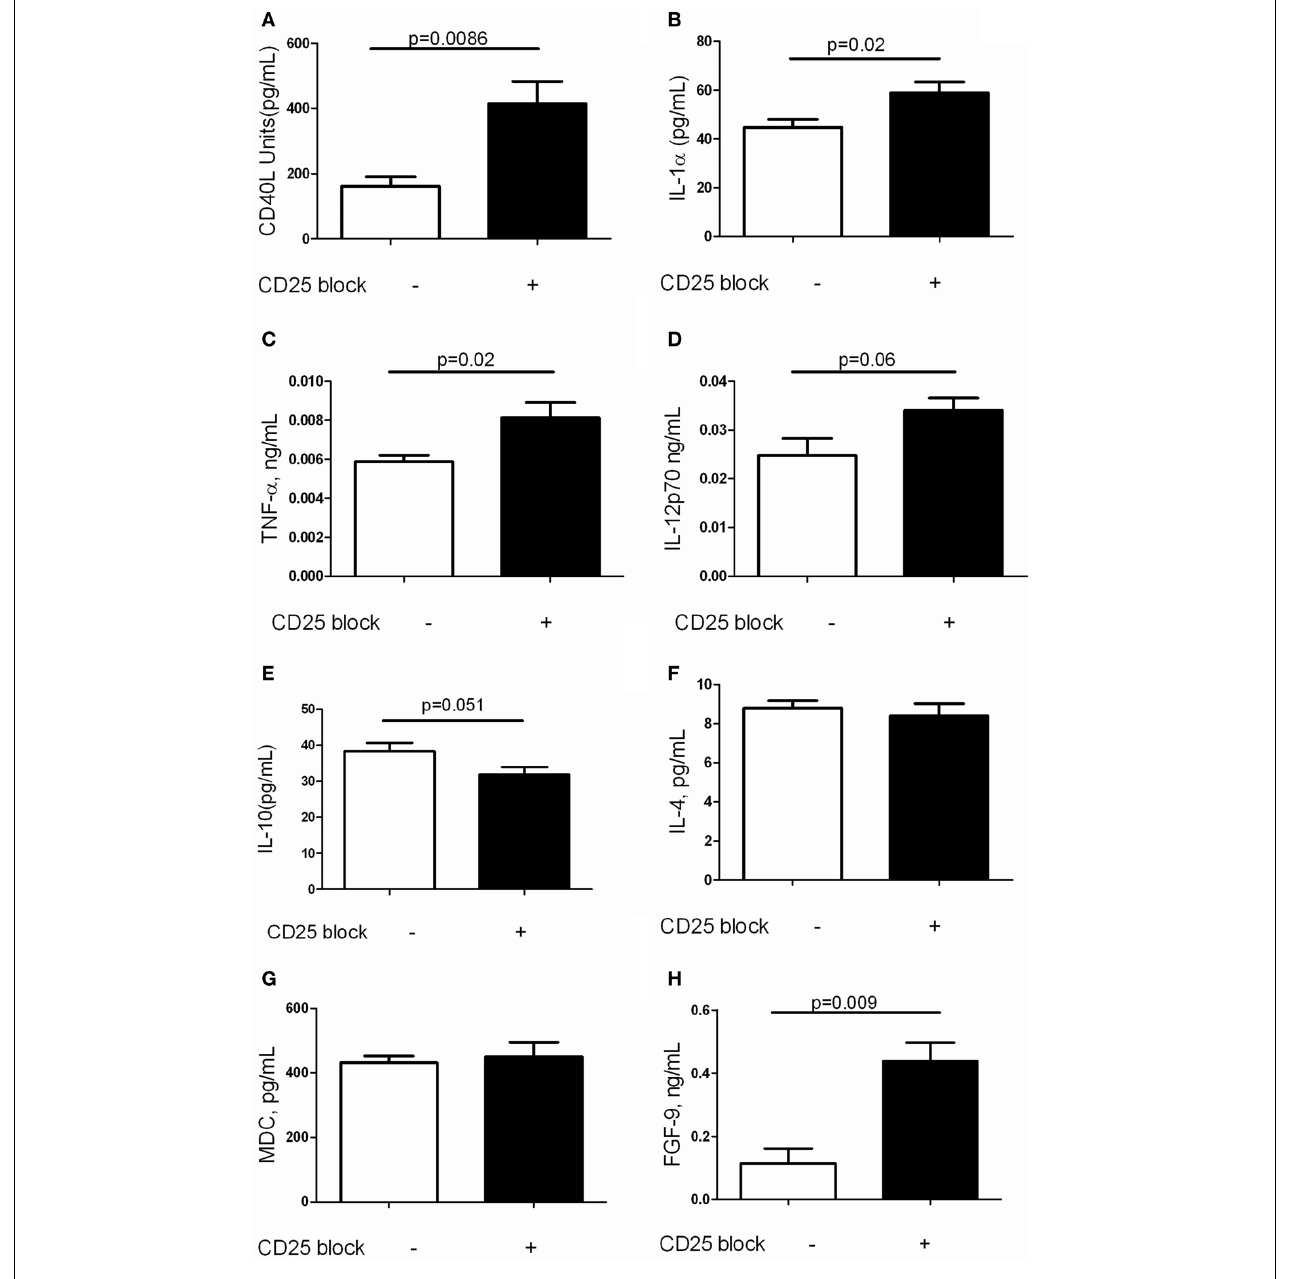
FIGURE 4 | Depletion of Tregs amplifies expression of inflammatory markers and FGF9 in the TGF- β 1 exposed mouse lung. Soluble mediators in the BAL fluid of TGF- β 1 Tg + mice given doxycycline for 14 days and treated with isotype or anti-CD25 neutralizing antibody were